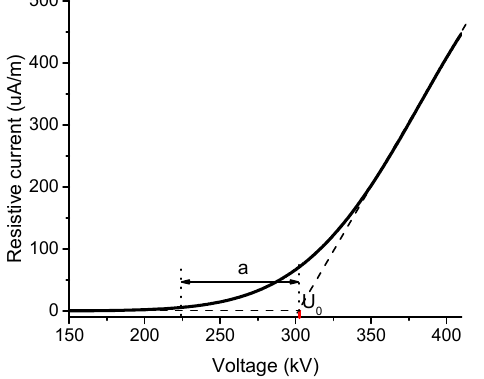
Figure 4. The diagram for determining the onset voltage using the U-I curve tangent line method.